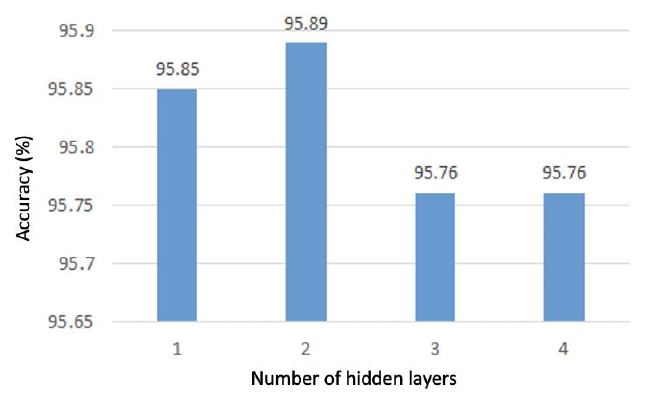
Figure 8. Evaluation results of artificial neural network (ANN) models with different hidden layers.